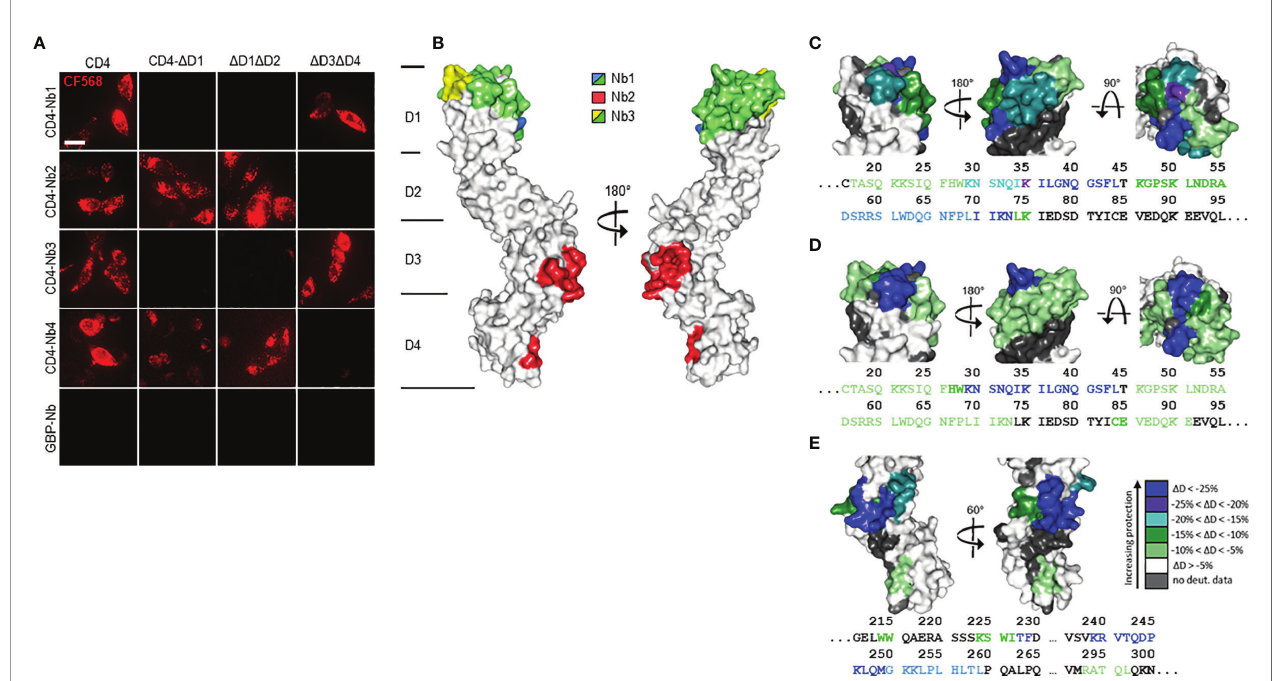
FIGURE 2 | Localization of CD4-nanobody (Nb) binding epitopes. (A) Representative images of live CHO cells expressing full-length or domain-deletion mutants of human CD4 (hCD4) stained with fl uorescently labeled CD4-Nbs (CF568) are shown; scale bar 10 µm. (B) Surface structure model of hCD4 (PDBe 1wiq) (36) and the hydrogen-deuterium exchange mass spectrometry (HDX-MS) epitope mapping results of CD4-Nb1 – 3 are depicted. Different colors highlight the amino acid residues protected by CD4-Nb1 (blue), CD4-Nb2 (red), or CD4-Nb3 (yellow). Overlapping residues protected by both Nb1 and Nb3 are colored green. A more detailed surface map (% D D) of these speci fi c regions is highlighted in (C) (CD4-Nb1), (D) (CD4-Nb3), and (E) (CD4-Nb2) with the corresponding CD4 amino acid